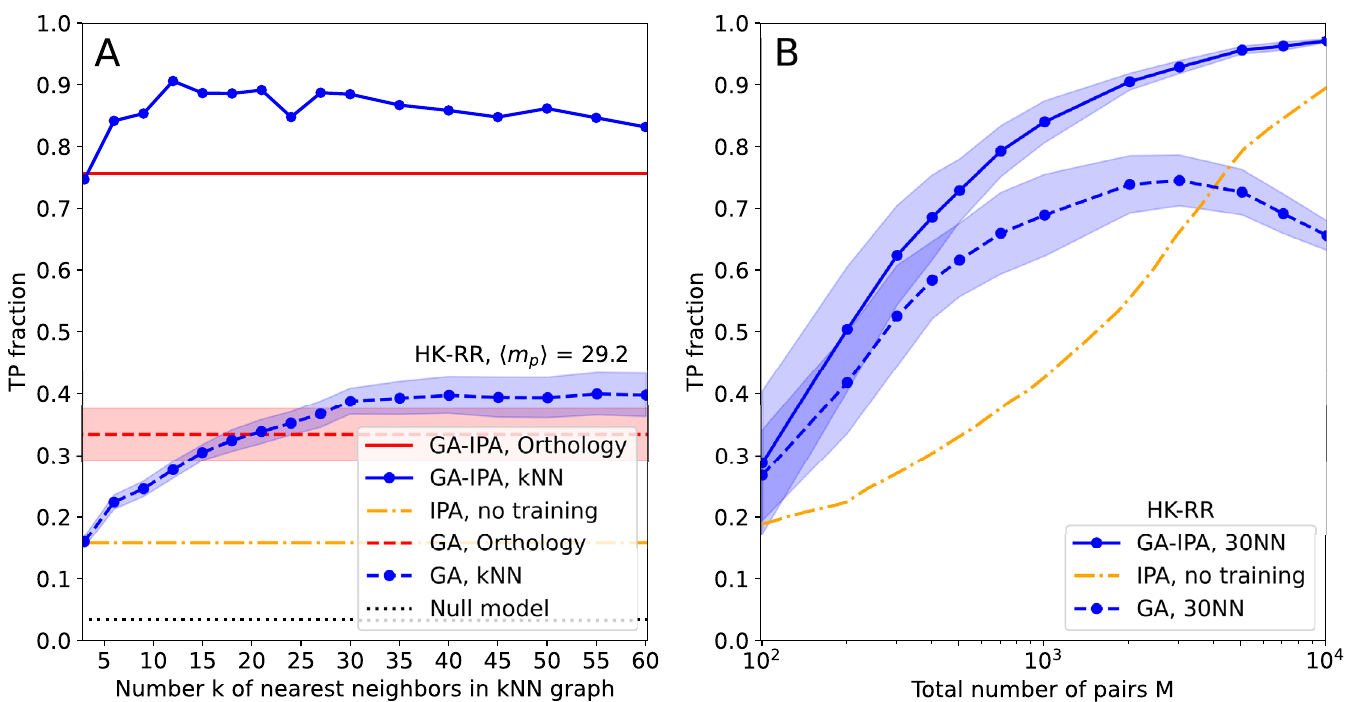
Fig 5. Robust performance of GA-IPA in hard cases of paralog pairing. (A) Same as Fig 4 but on a dataset having on average 29.2 paralogs per species, compared to 11.03 in Fig 4. While the performance of GA is substantially reduced compared to Fig 4, and that of IPA is even more reduced, GA-IPA achieves much larger TP fractions than GA and IPA. (B) Results of GA, IPA and GA-IPA for smaller datasets obtained by species subsampling from the full HK-RR data set, with 11.1 paralogs per species on average. We observe that GA-IPA needs almost one order of magnitude less sequences than IPA to reach comparable TP fractions.